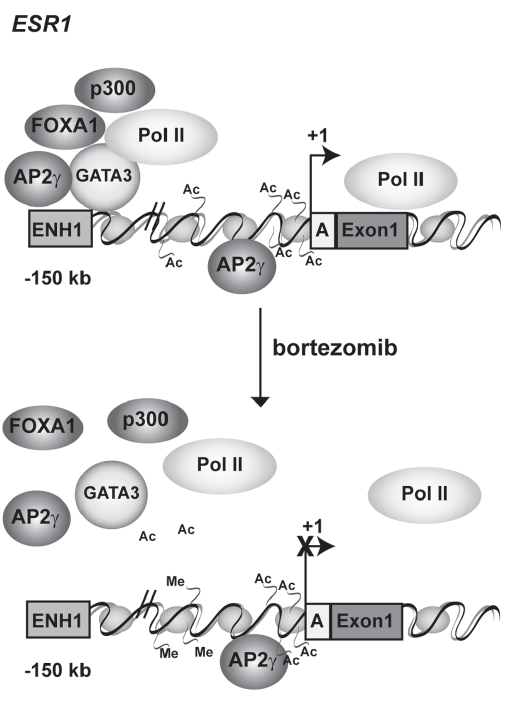
Figure 6. Model of ESR1 regulation by proteasome inhibitors. Under basal conditions in the absence of estrogen, the ESR1 distal enhancer is acetylated on histones H3 and H4, and is occupied by FOXA1, AP2 c , GATA3, p300 and RNA PolII. Histone H3 and H4 are also acetylated on the proximal promoter which is occupied by RNA PolII and AP2 c . After the addition of bortezomib, the distal enhancer exhibits decreased histone acetylation and increased histone methylation. Occupancy of FOXA1, AP2 c , GATA3, p300 and RNA PolII decreases on the distal enhancer. In contrast, histone acetylation, methylation, and AP2 c occupancy on the proximal promoter are unchanged, but RNA PolII occupancy decreases. These data support a model where bortezomib-induced changes in the chromatin environment around the distal enhancer regulate ESR1 expression in ER + breast cancer cells.